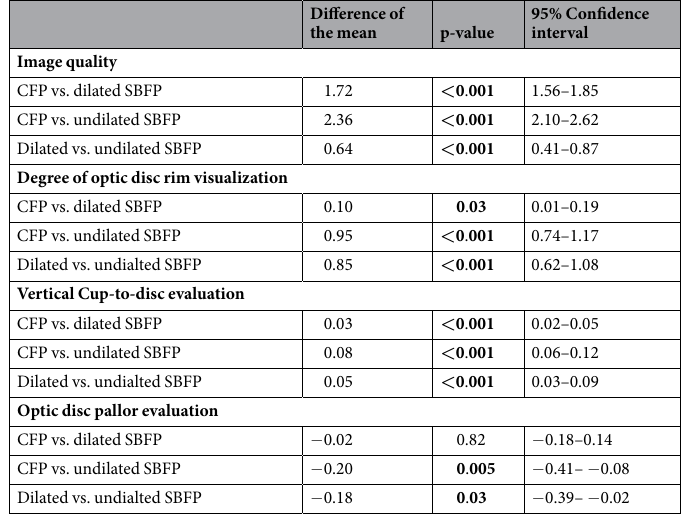
Table 2. Parametric testing for the comparison of the different imaging modalities. CFP = conventional fundus photography; SBFP = Smartphone-based fundus photography.